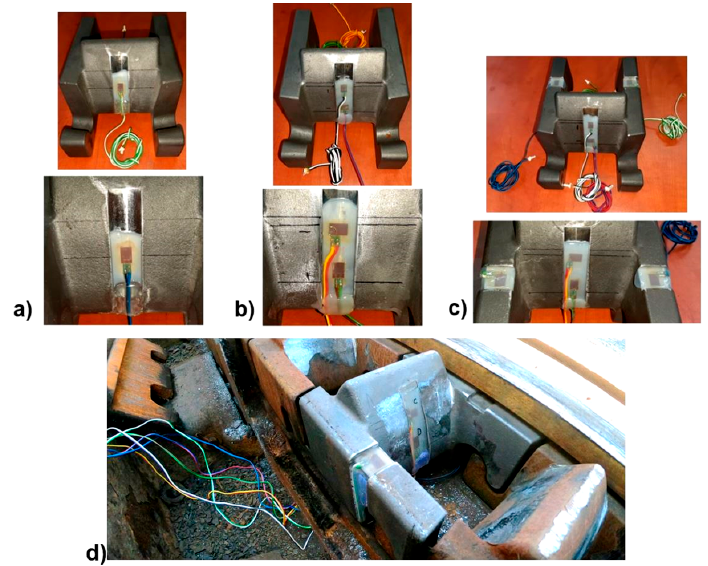
Figure 17. View of toothed segments prepared for tests with use of electric resistance strain gauges with glued strain gauges in the number: ( a ) two, ( b ) four, ( c ) six and ( d ) view of one segment with glued strain gauges installed in the guide.